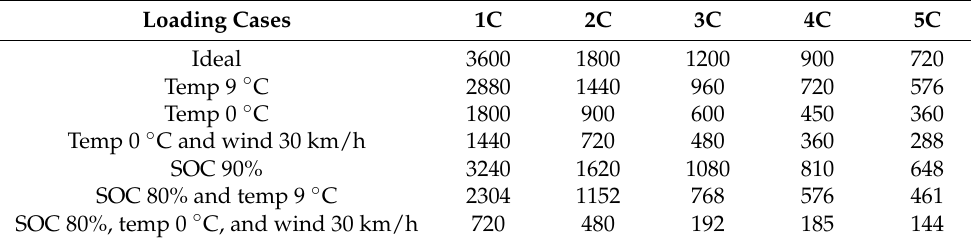
Table 3. Theoretical time limits (in sec unit; the meaning of 1C...5C can be seen in Figure